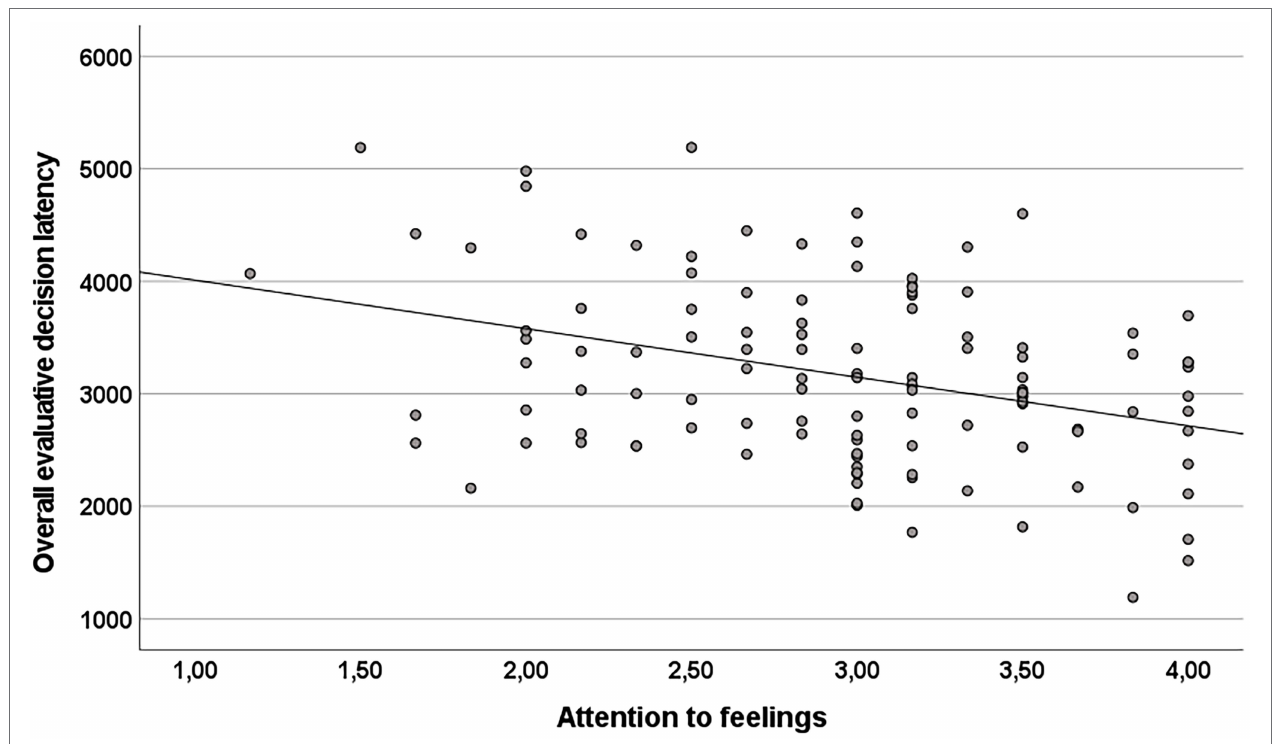
FIGURE 2 | The scatterplot depicts the negative correlation between dispositional attention to feelings as assessed by the WEFG (mean item score) and overall evaluative decision latency (in milliseconds) in the PFE task ( r = − 0.35, p < 0.001; N =